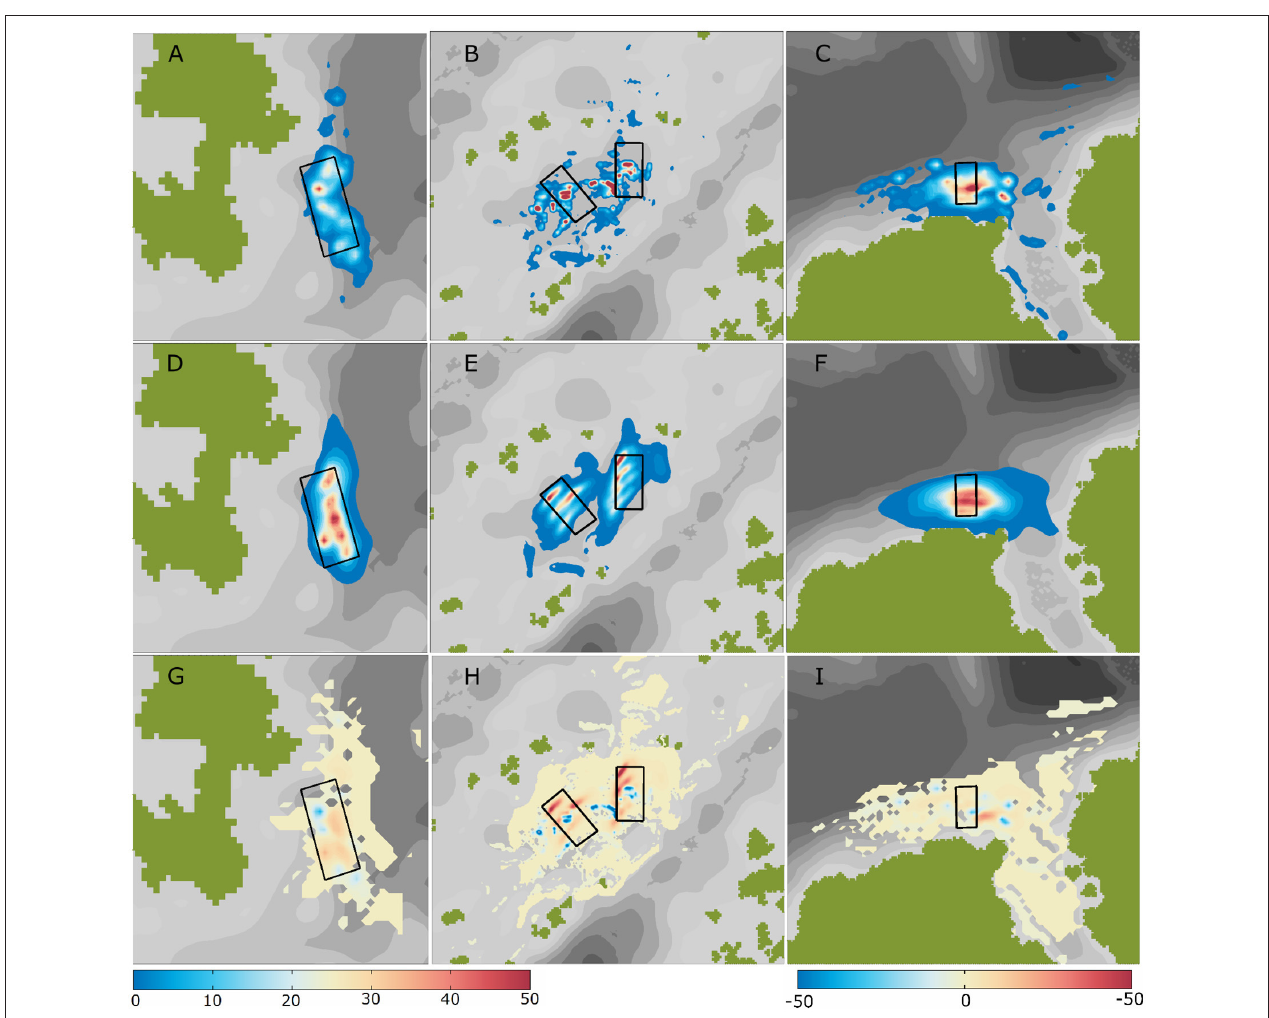
FIGURE 7 | Simulated mud thickness (mm) at the time of the MOM surveys ( Table 1 ) at locations 1–3 (top to bottom panels). (A–C) Results from the simulations with resuspension processes. (D–F) Results from the simulations without resuspension processes. (G–I) Plots of the differences in simulated mud thickness between the simulations without and with resuspension. The cage arrays are 200m wide. The colors indicated mud thickness (mm) (left bar, A–F ) and differences in mud thickness (mm) (right bar, G–I ). The shade of gray indicate bottom depth.